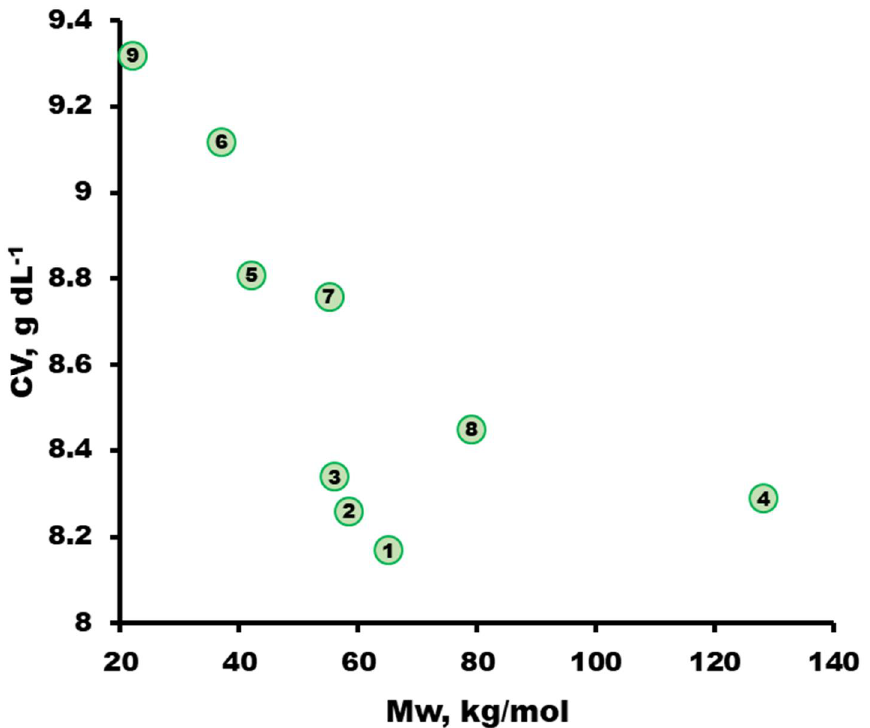
Figure 4. Coagulation values dependence obtained by titration of 2 wt.% polymer solution of synthesized PSF in NMP by water. The sample numbers are the same as those in Table 3.